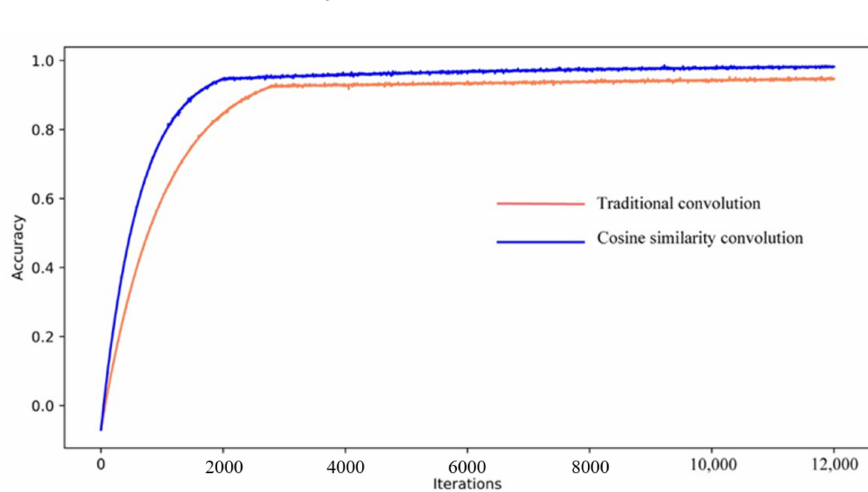
Figure 14. Loss curve for training.